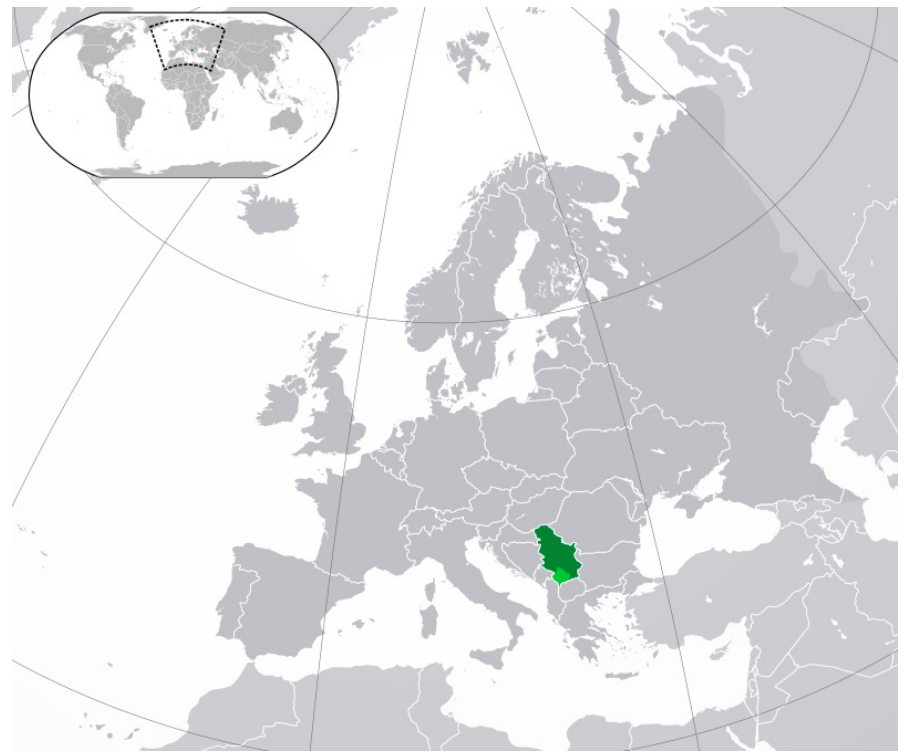
Figure 1. Location of Serbia (dark grey) in the Europe (grey) [10].